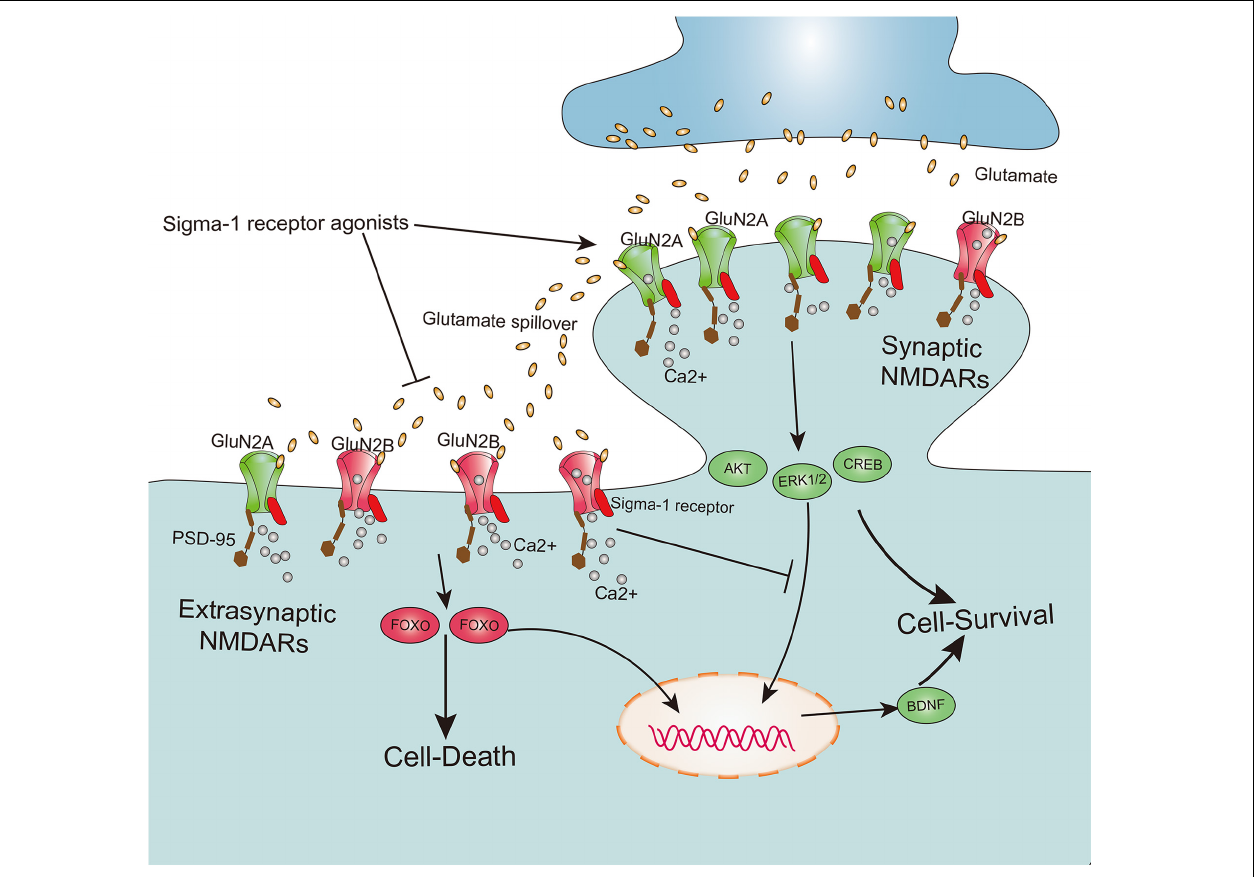
FIGURE 3 | Sigma-1 receptor determines cell fate by modulation extrasynaptic NMDARs and synaptic NMDARs activities. The subunit GluN2A and GluN2B, respectively, are mainly existed on synaptic and extrasynaptic regions. Both synaptic NMDARs and extrasynaptic NMDARs contribute to calcium transients which trigger a series of nuclear calcium-dependent signaling pathways. They lead to totally opposing biochemical processes and cellular consequences, in which activation of synaptic NMDARs promote cell survival by upregulation of the expression of extracellular signal-regulated kinase 1/2 (ERK1/2), protein kinase B (Akt), cAMP response element-binding protein (CREB) and brain-derived neurotrophic factor (BDNF), whereas excessive activation of extrasynaptic NMDARs lead to cell death by contribution to CREB shut-off, inactivation Akt and ERK1/2, and activation of pro-death transcription factor forkhead box protein O (FOXO). Agonism of sigma-1 receptor not only promotes the synaptic NMDARs activities, but also inhibits extrasynaptic NMDARs